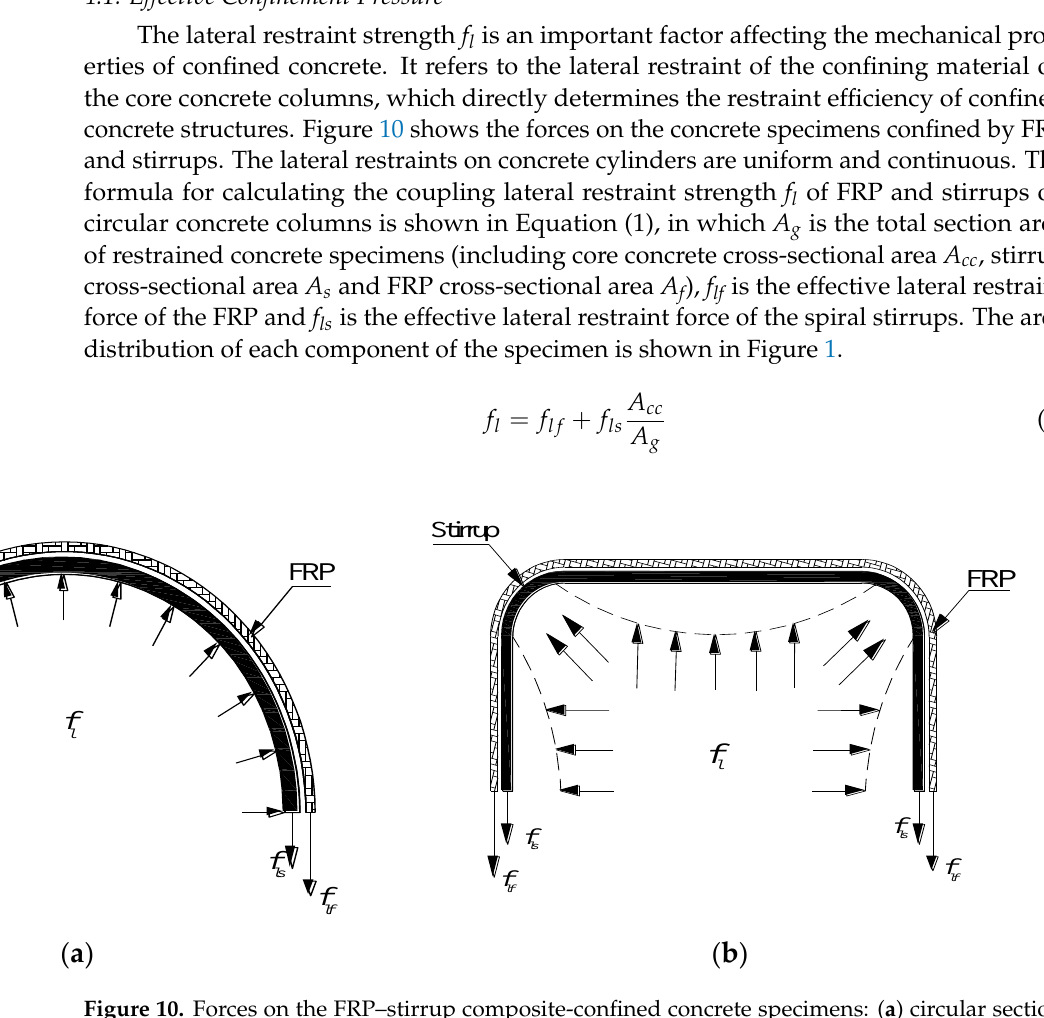
Figure 10. Forces on the FRP–stirrup composite-confined concrete specimens: ( a ) circular section; ( b ) rectangular section.